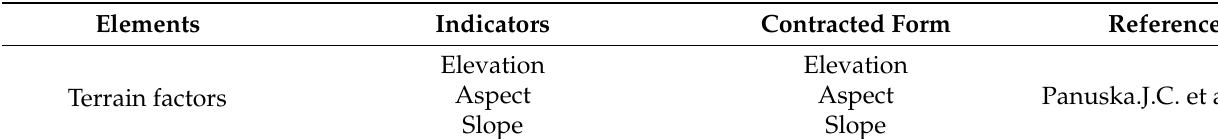
Table 1. Indicators of terrain, human society and economy and land use.